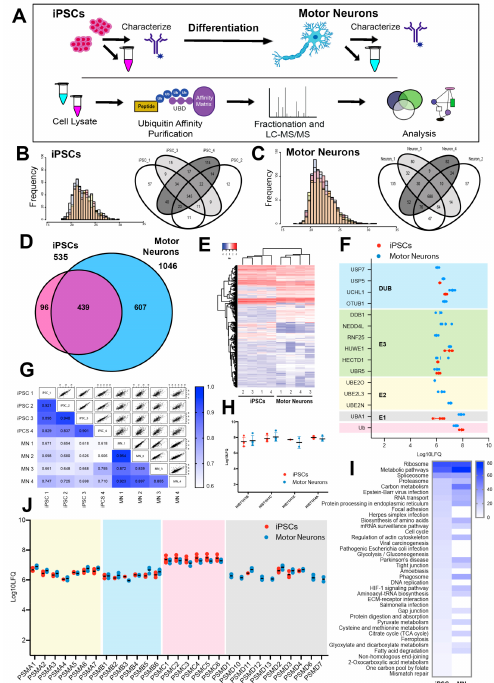
Figure 2. Defining the ubiquitome in iPSCs and iPSC-derived motor neurons. ( A ) Schematic of sample collection from iPSC and iPSC-derived motor neurons ( n = 4), and processing for analysis. ( B ) Histograms showing distribution of peptide intensities in individual replicates and Venn diagrams showing number of proteins identified in the ubiquitome in individual replicates of iPSC. ( C ) Histograms showing distribution of peptide intensities in individual replicates and Venn diagrams showing number of proteins identified in the ubiquitome in individual replicates of motor neurons. ( D ) Venn diagram showing number of individual proteins identified in the ubiquitome of iPSC and iPSC-derived motor neurons. ( E ) Hierarchical clustering showing relationship of individual replicates of iPSC and motor neuron ubiquitomes. ( F ) Abundance of individual Ub pathway components in the ubiquitome of iPSC and iPSC-derived motor neurons. Data shown are mean ± SEM; n = 4. ( G ) Multiple regression analysis of protein abundances (LFQ) in individual replicates, showing Pearson’s correlation values. ( H ) Abundance (LFQ) of histone variants in the ubiquitome of iPSC and motor neurons. ( I ) Heat map showing functional enrichment (using KEGG pathways) in the ubiquitome of iPSC and motor neurons (shading relative to number of individual proteins represented in each pathway). ( J ) Abundance (LFQ) of proteasome subunits in the ubiquitomes of iPSCs and motor